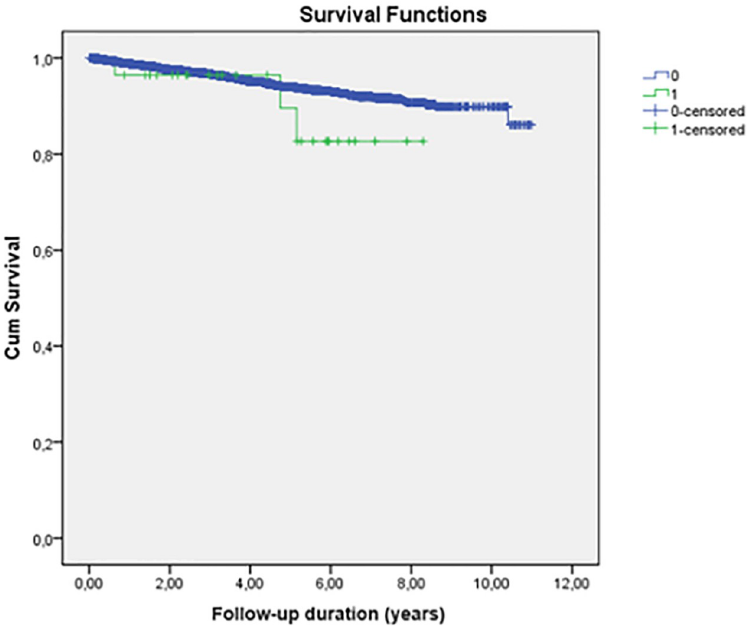
Fig 4. Survival in relation patients with TNF inhibitors use with deaths due to general causes and deaths due to tuberculosis. (p = 0,20 by log rank test). 0 = deaths from all causes. 1 = deaths due to tuberculosis.